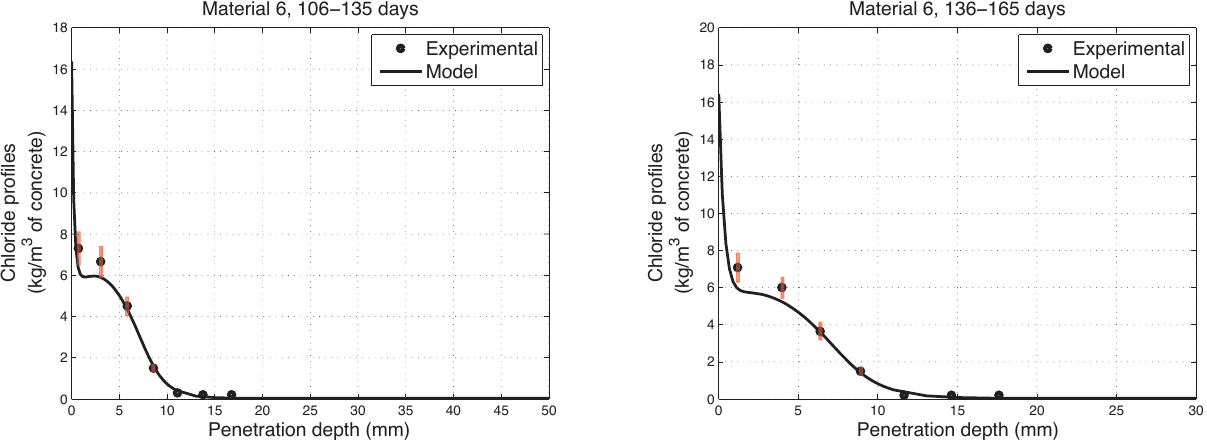
Figure 9. Experimental versus numerical solution for material mat6 and environments 3 (106–135 days) and 4 (136–165 days).